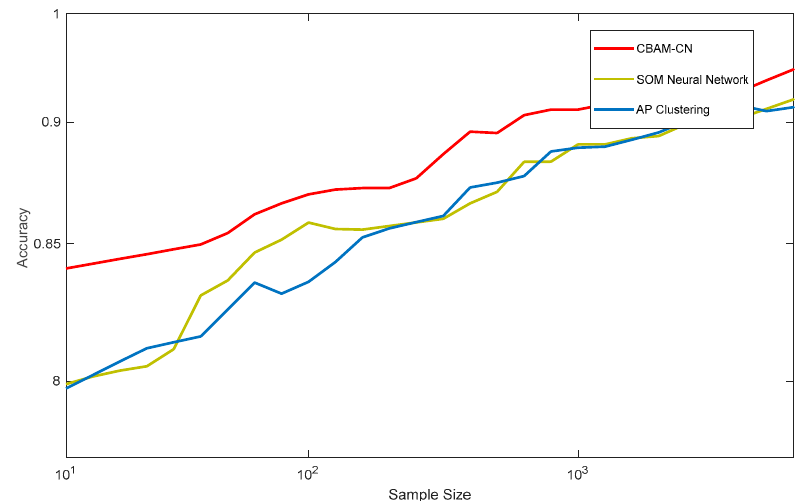
Figure 11. The relationship between the accuracy and the number of samples.